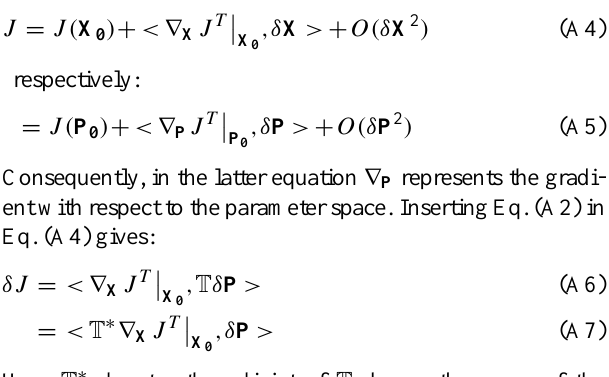
Fig. 4. Temporal correlations of the changes induced by the as- similation procedure: Correlations between changes in the model’s meridional surface velocity and the change in modeled χ 1 (top) re- spectively χ 2 (bottom).